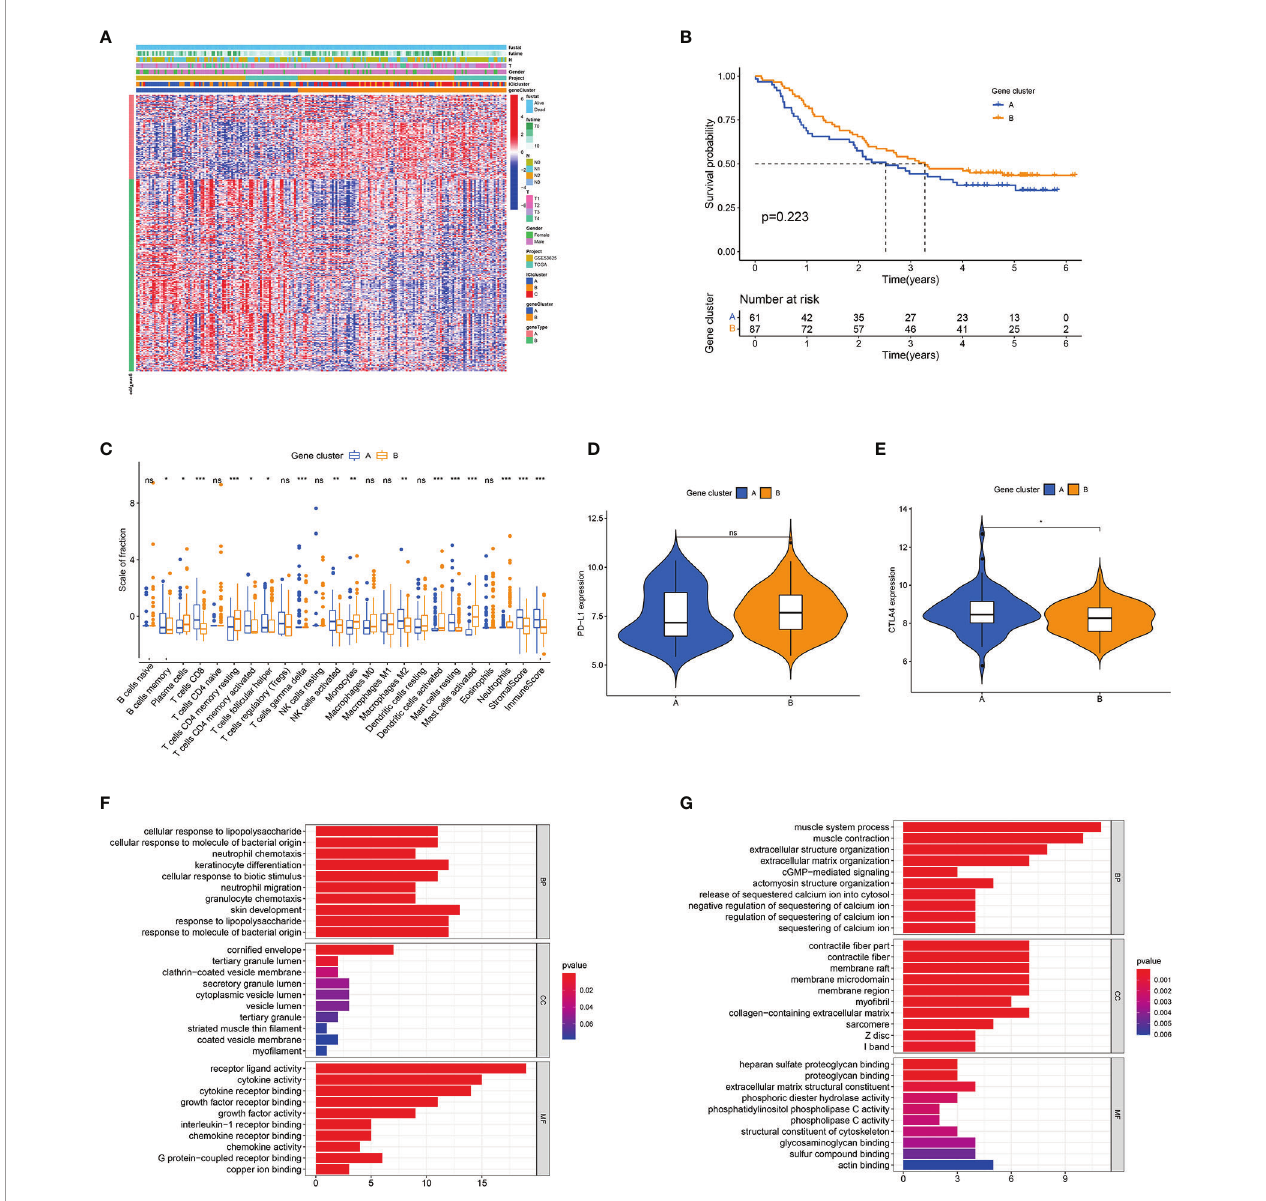
FIGURE 2 | Identi fi cation of immune gene subtypes. (A) Unsupervised clustering of DEGs among three ICI clusters in ESCC cohorts. (B) Kaplan – Meier curves for patients in gene clusters A and (B) Log-rank test P = 0.040. (C) Box plot of in fi ltrating immune cell fractions in gene clusters A and (B) The immune and stromal scores of the two gene clusters are also plotted. (D, E) Expression levels of PD-L1 (D) and CTLA4 (E) between the two gene clusters. (F, G) GO enrichment analyses of ICISGA (F) and ICISGB (G) . The X-axis represents the number of genes within each GO term. * P < 0.05; ** P < 0.01; *** P < 0.001; ns, no signi fi